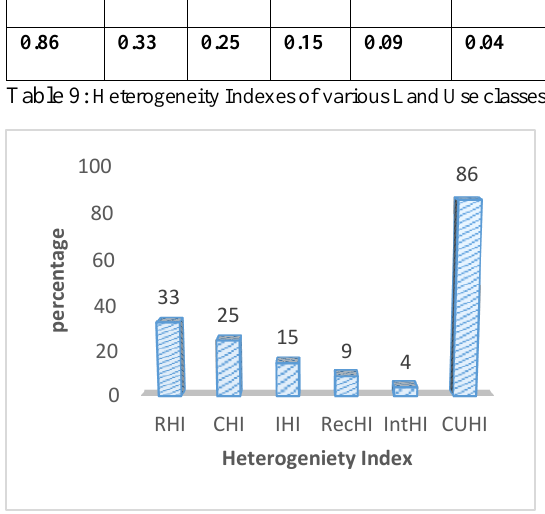
Figure 10: Percentage Contribution of Heterogeneity Index to Traffic Congestion